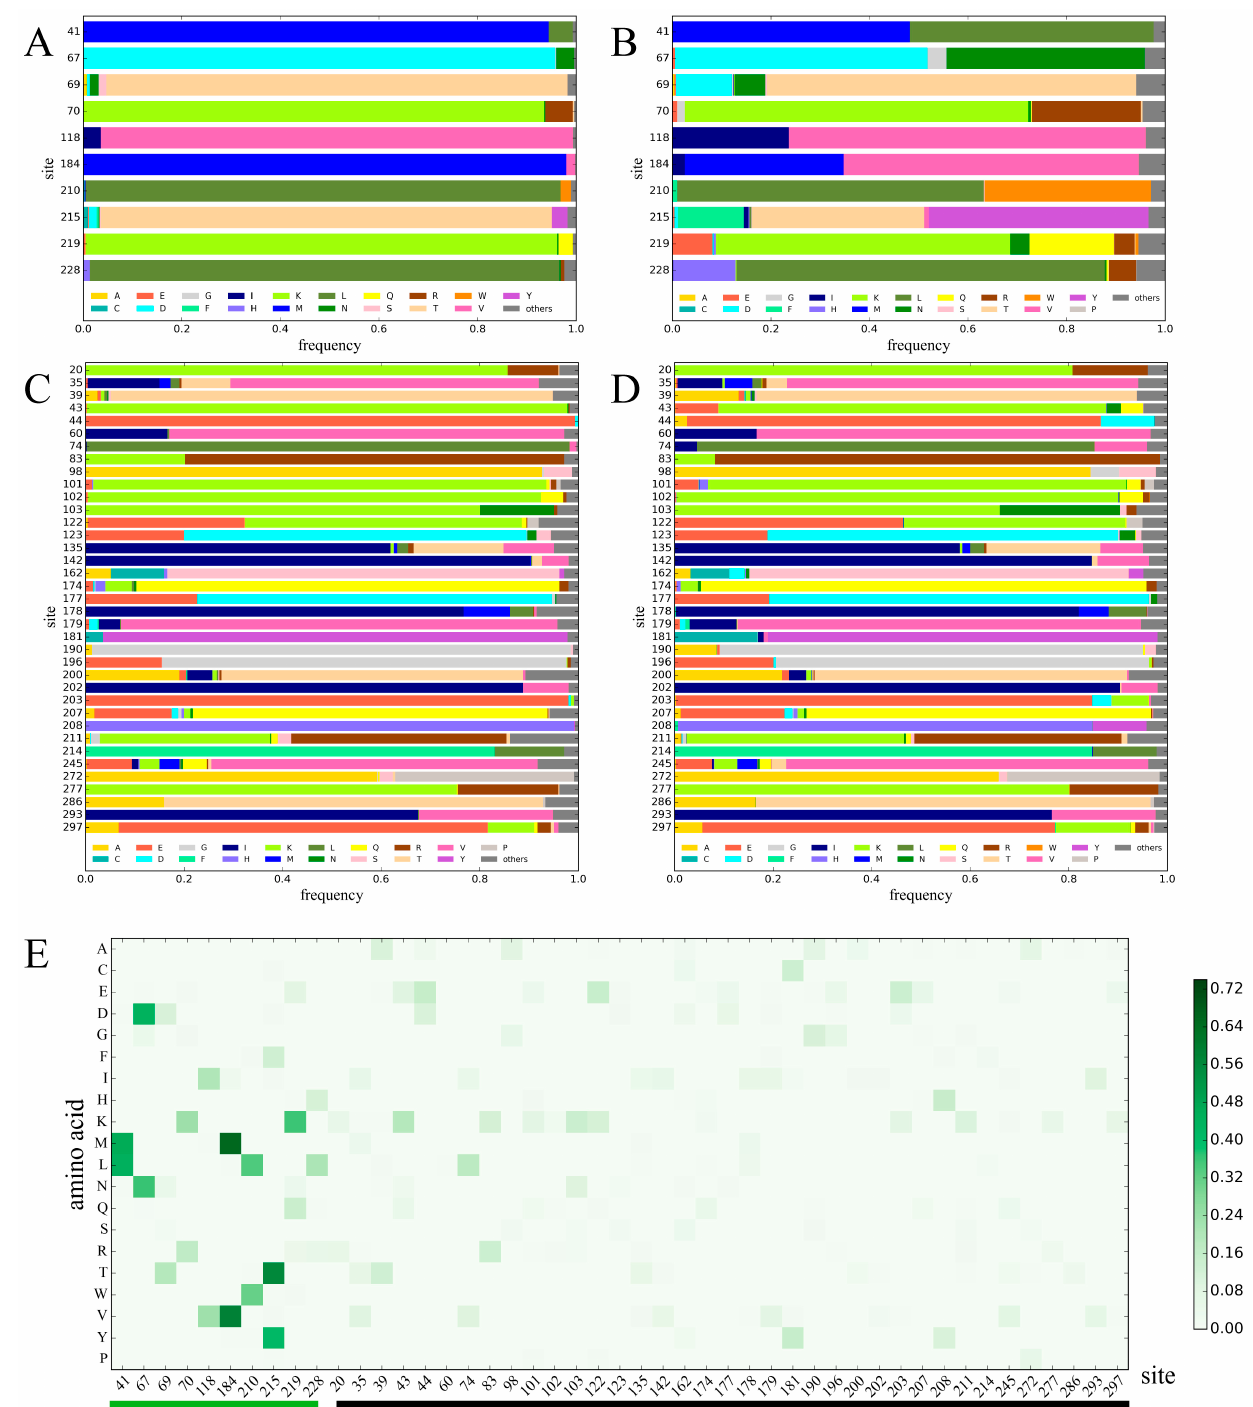
Figure 5. Amino acid distribution and frequency changes of 3TC-susceptible and 3TC-resistant proteins on 47 sites. Sub- graphs ( A , B ) show the amino acid frequencies on 10 dominant sites for 3TC-susceptible proteins and 3TC-resistant proteins, respectively. Sub-graphs ( C , D ) show the amino acid frequencies on 37 mutation sites for 3TC-susceptible proteins and 3TC-resistant proteins, respectively. Sub-graph ( E ) illustrates the absolute difference of residue frequency on each site between 3TC-susceptible and 3TC-resistant proteins. The X axis refers to each mutation site. The Y axis refers to 20 amino acids. Each pixel refers to the value of DF(a i ,s j ) for each amino acid a i on 47 sites s j . The color of each pixel correlates to the value of DF(a i ,s j ) .